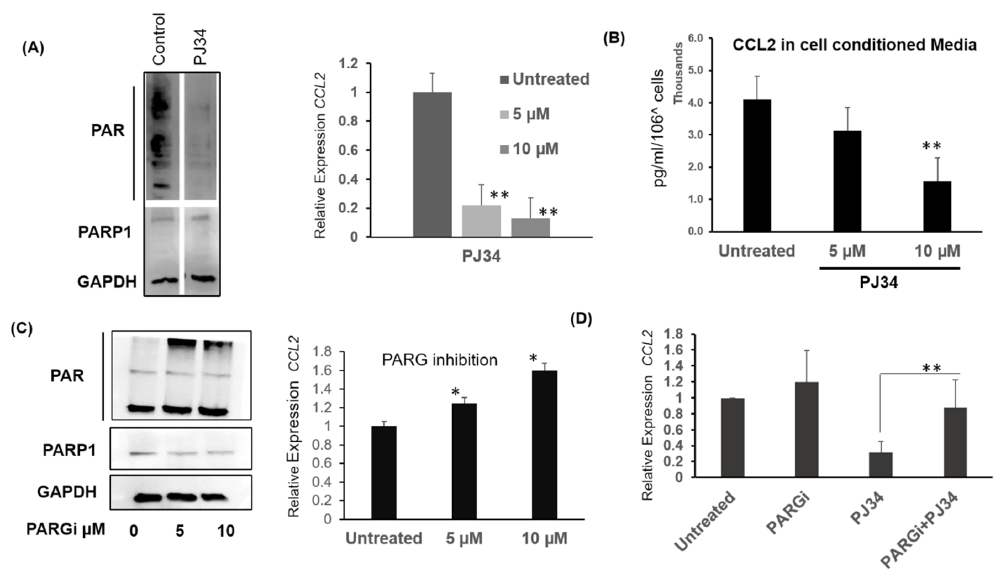
Figure 3. Modulating intracellular PAR levels affects CCL2 transcription. ( A ) PAR and PARP1 levels after overnight 10 µM PJ34 treatment in MB-231cells. Left: Western bolt showing PARP1 and PAR levels. Right: Relative CCL2 transcript levels after overnight PJ34 treatment in MB-231with